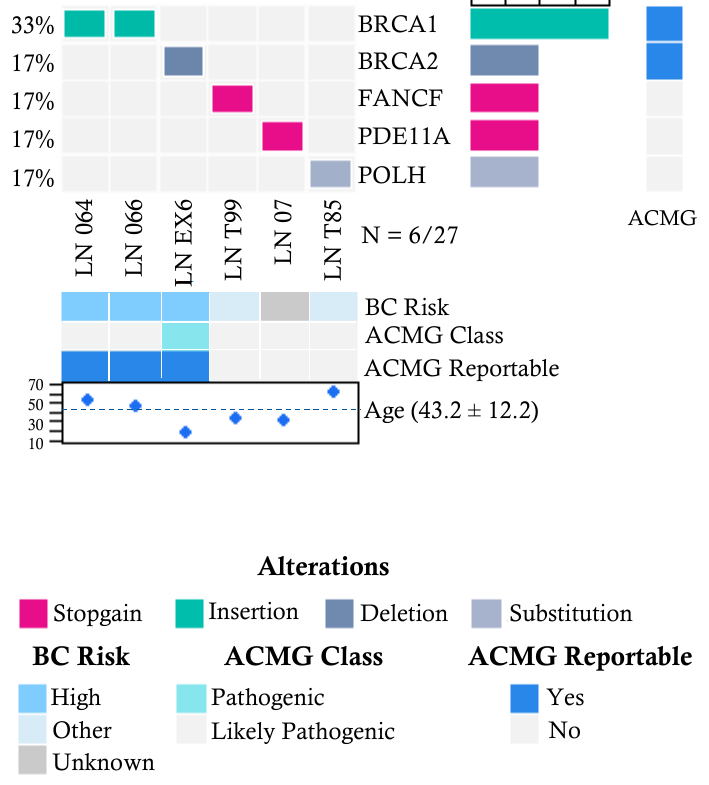
Figure 2. Allelic distribution of the pathogenic variants in high-risk patients with a severe family history of cancer. The grid panel depicts the pathogenic mutations found in each patient color-coded for each type. Right panel: gene reportable by the suggestion of the ACMG (light blue = yes, gray = no). Bottom axis: patient ID. Left axis: relative frequency of mutations per gene. Right axis: mutated gene. Right bar plot: absolute frequency and type of pathogenic mutation per gene. Bottom panel indicates: risk associated with a pathogenic variant; ACMG variant class (pathogenic, likely pathogenic); gene reportable by the suggestion of the ACMG (light blue = yes, gray = no); age distribution.